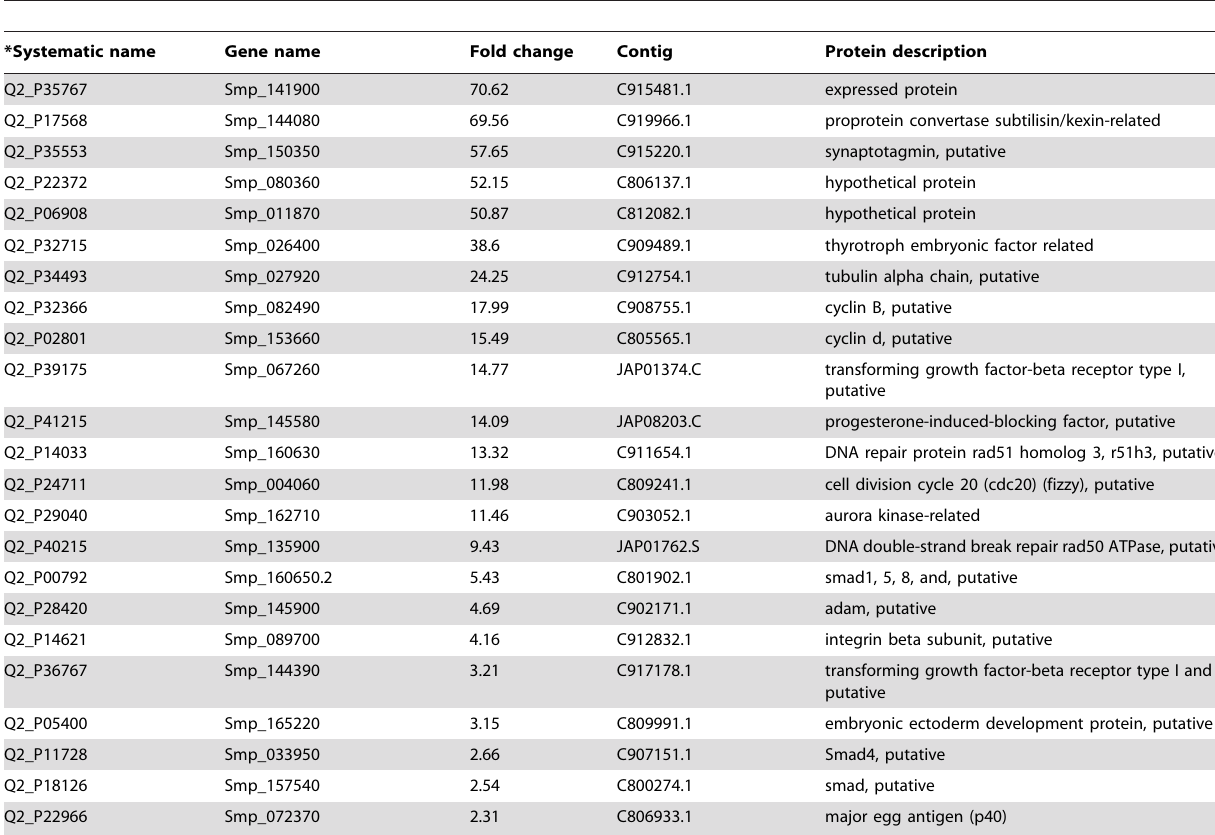
Table 3. A selection of differentially up-regulated genes of the ovary normalised to the whole female